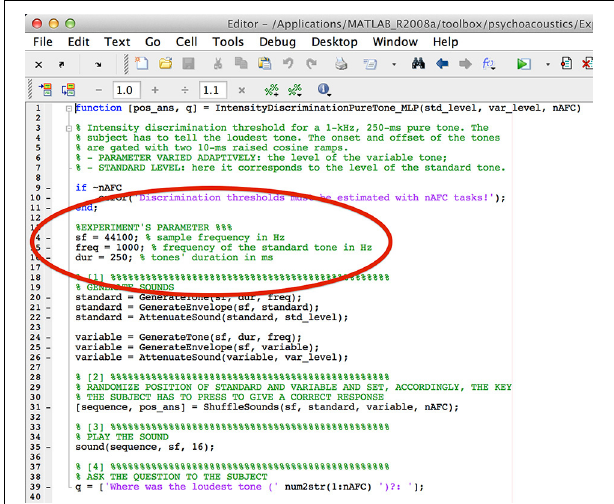
FIGURE 6 | Screenshot of the IntensityDiscriminationPureTone.m file.